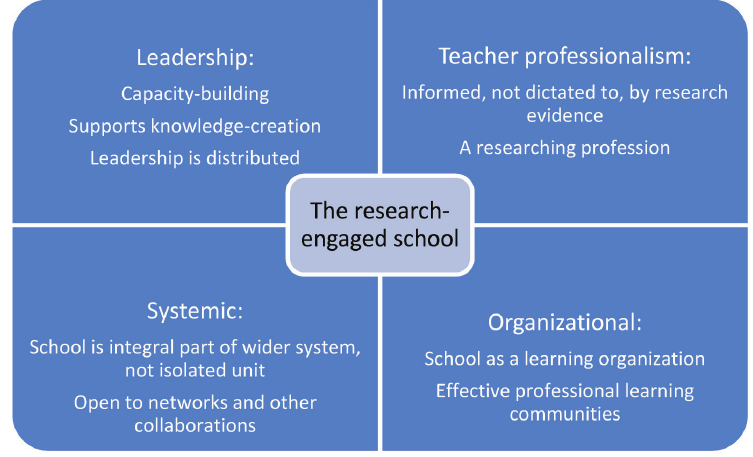
Figure 1: The research-engaged school learning